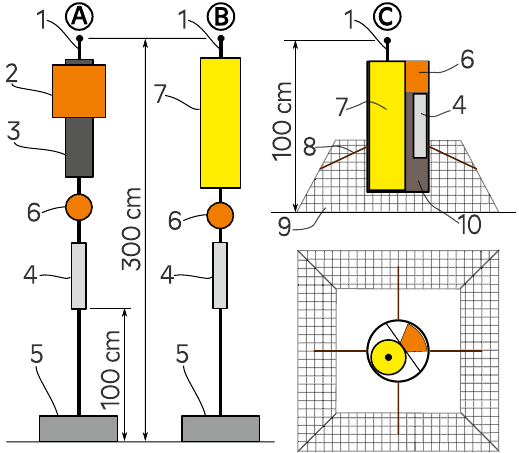
Figure 10. Sketch of the three BIAS standard rigs marked with letters A,B,C; 1-hydrophone, 2-extra buoyancy, 3-DSG Ocean recorder, 4-acoustic releaser, 5-ballast (min 20 kg wet weight), 6-buoy, 7-SM2M recorder, 8-rope, 9-steel grid cage, 10-rope container 35 .